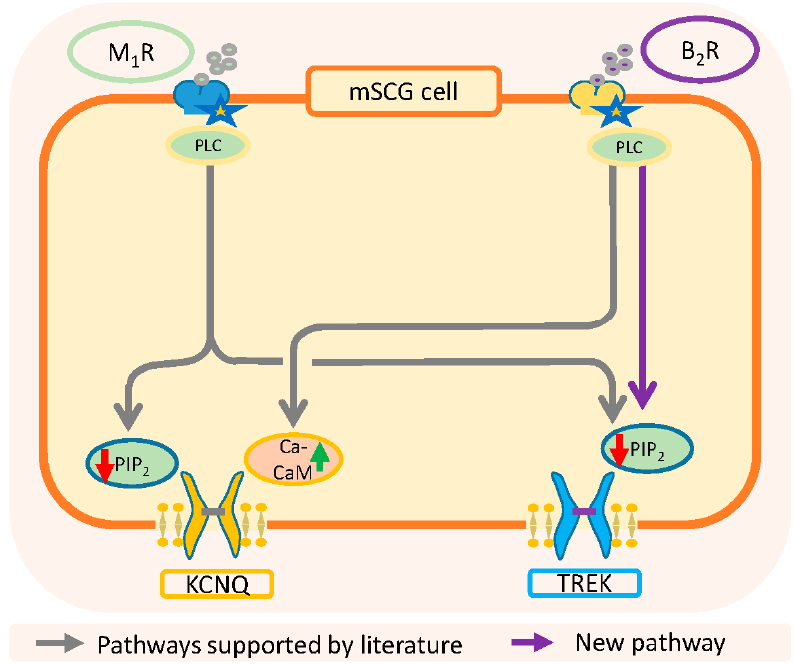
Figure 8. Summary of classical and new pathways involved in the resting membrane potential and excitability of SCG neurons. KCNQ: gen codifying M-type voltage dependent K channels.